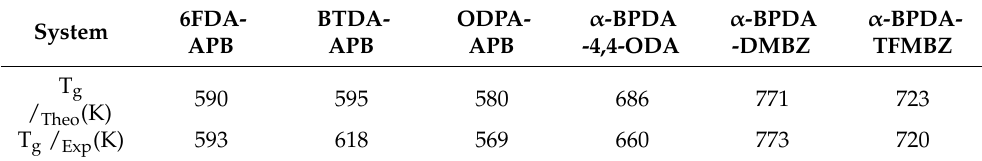
Table 2. T g of each model.